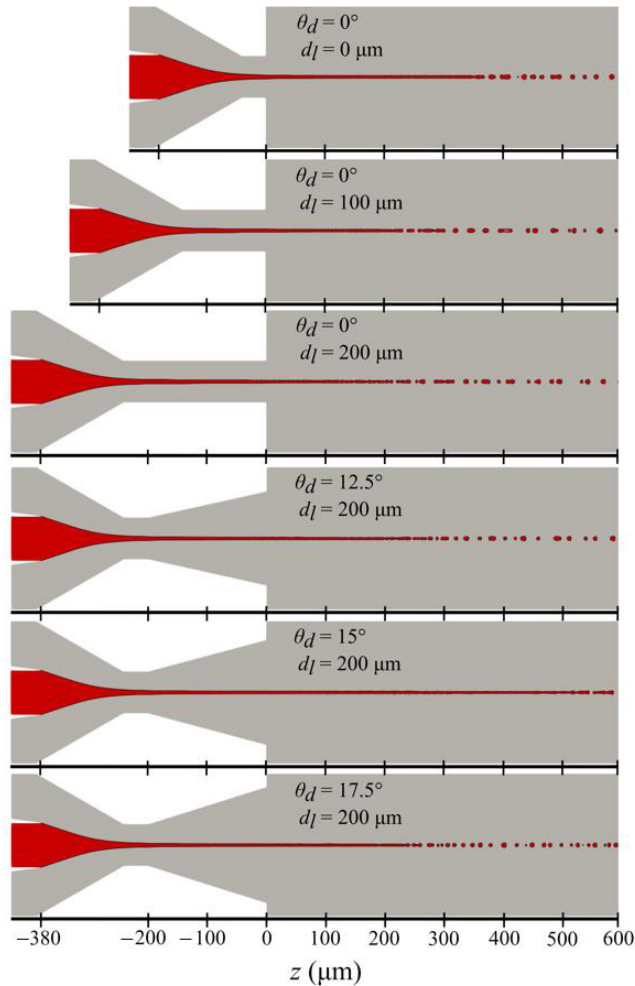
Figure 6. A plot of the jet shape at 0.8 ms for selected 6 nozzle outlet orifice variants from Table 3.